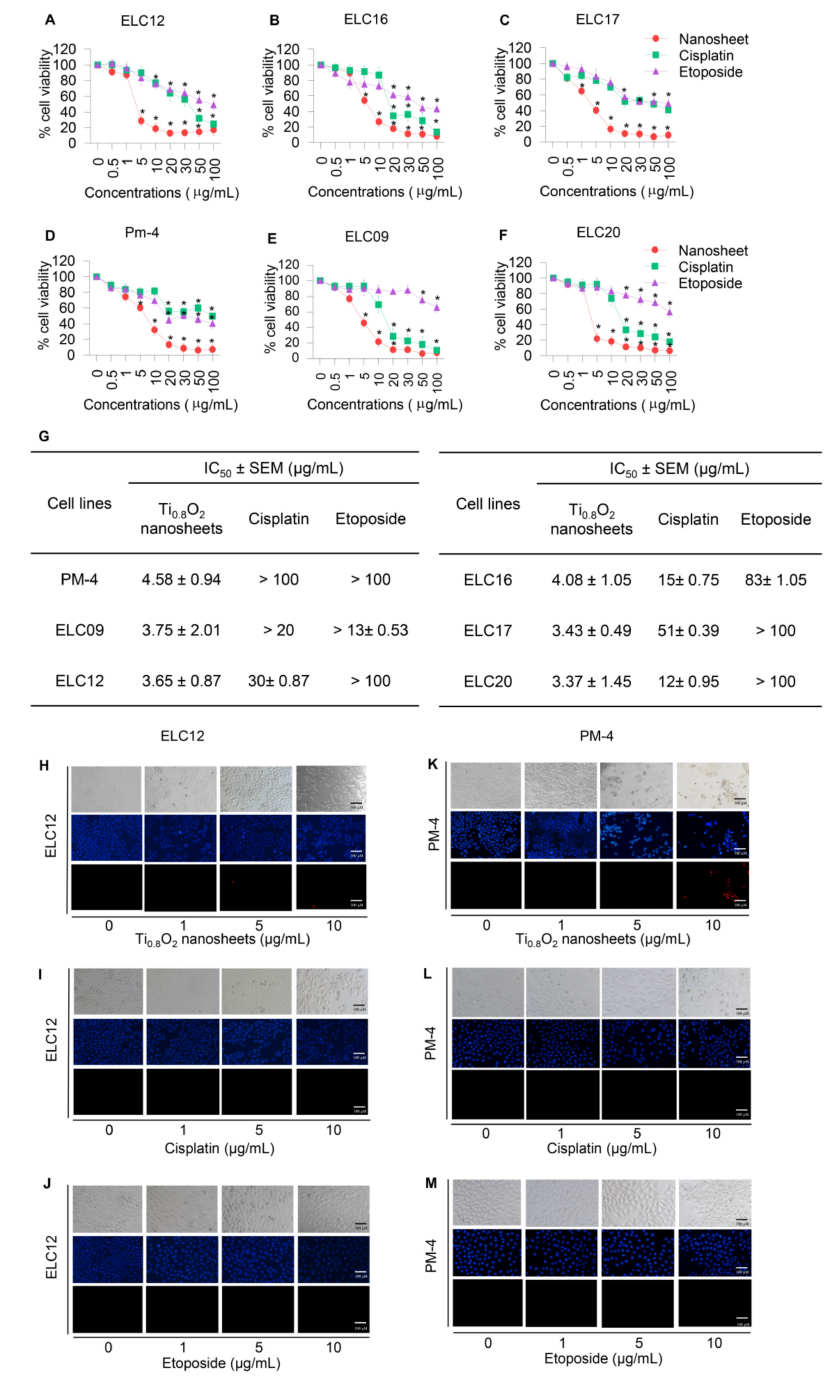
Figure 4. Cytotoxicity of the Ti 0.8 O 2 nanosheets on malignant pleural effusion from advanced lung cancer patients. ( A – F ) Effect of the Ti 0.8 O 2 nanosheets on the cell viability of malignant pleural effusion for 24 h using an MTT assay to determine the IC 50 values; ( G ) percentages of cell viability were determined using an MTT assay; ( H – M ) morphology of apoptotic nuclei stained with Hoechst 33342 dye and propidium iodide in cells treated with Ti 0.8 O 2 nanosheets; cisplatin and etoposide were determined by visualization under a fluorescence microscope; the percentages of nuclear fragments and PI-positive cells were calculated. Data are shown as the mean ± SEM ( n = 3). * p < 0.05 versus non-treated